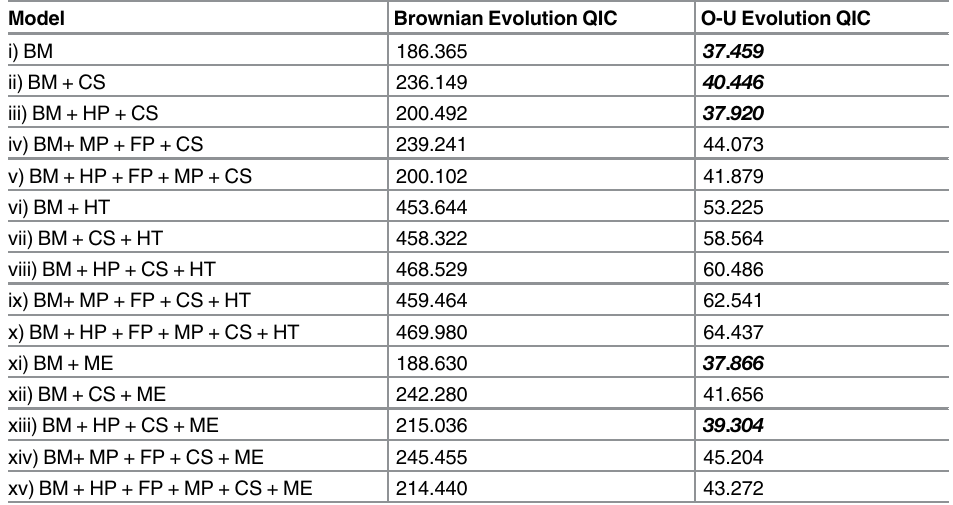
The model with the lowest QIC value (bold) represents the best balance of explanatory power and model complexity available from the suite of tested models. Models within 4 QIC of the best model (bold italics) still contain some explanatory